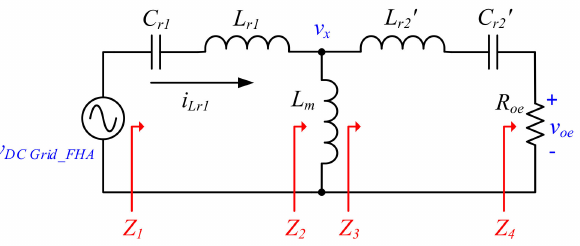
Figure 7. AC equivalent circuit of converter in the forward